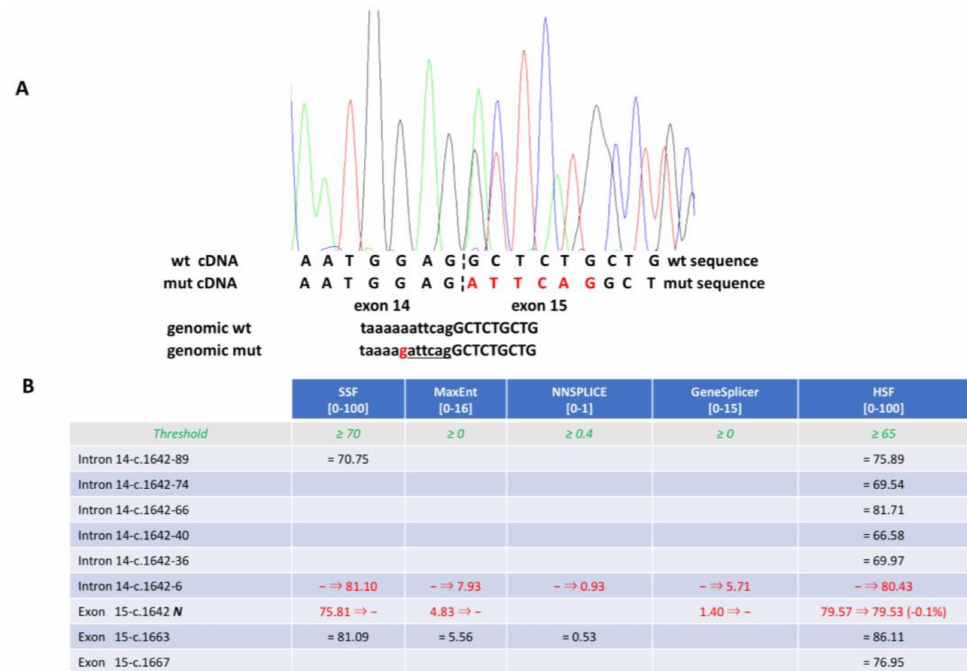
Figure 2. ( A ) Electrophoretogram of the complementary DNA (cDNA) generated from mutation c. 1640-7G>A. Below, the sequences of wild type and mutated cDNA and genomic DNA are presented. The inserted nucleotides are in red in the cDNA sequence. In the genomic sequences, the nucleotide substitution is in red, the nucleotides inserted in the cDNA are underlined. Small letters indicate the intronic sequence. ( B ) Predictions computed from the Alamut Visual splicing module. In the first row, the module’s splicing algorithms are presented; in the second row, the thresholds for the splicing site recognition for each individual algorithm are presented; in the remaining rows, all the putative splicing sites recognized by at least one of the algorithms of the Alamut Visual splicing module are presented. N indicates the natural splicing site. Green numbers indicate for each algorithm the threshold or range for splicing site recognition; red numbers are used when the computed scores predict splicing alteration; black numbers are used when the splicing site is recognized (above threshold or in the range) but no splicing alteration is forecasted. wt, wild type; mut,